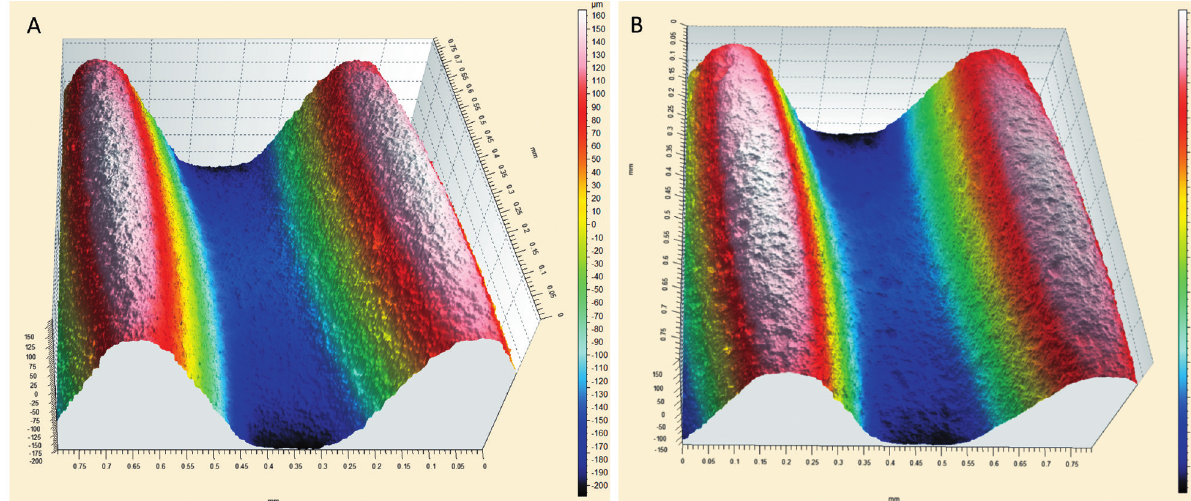
(Table 1). The contact angles between the drop solution and different surfaces are shown in Figure 3.